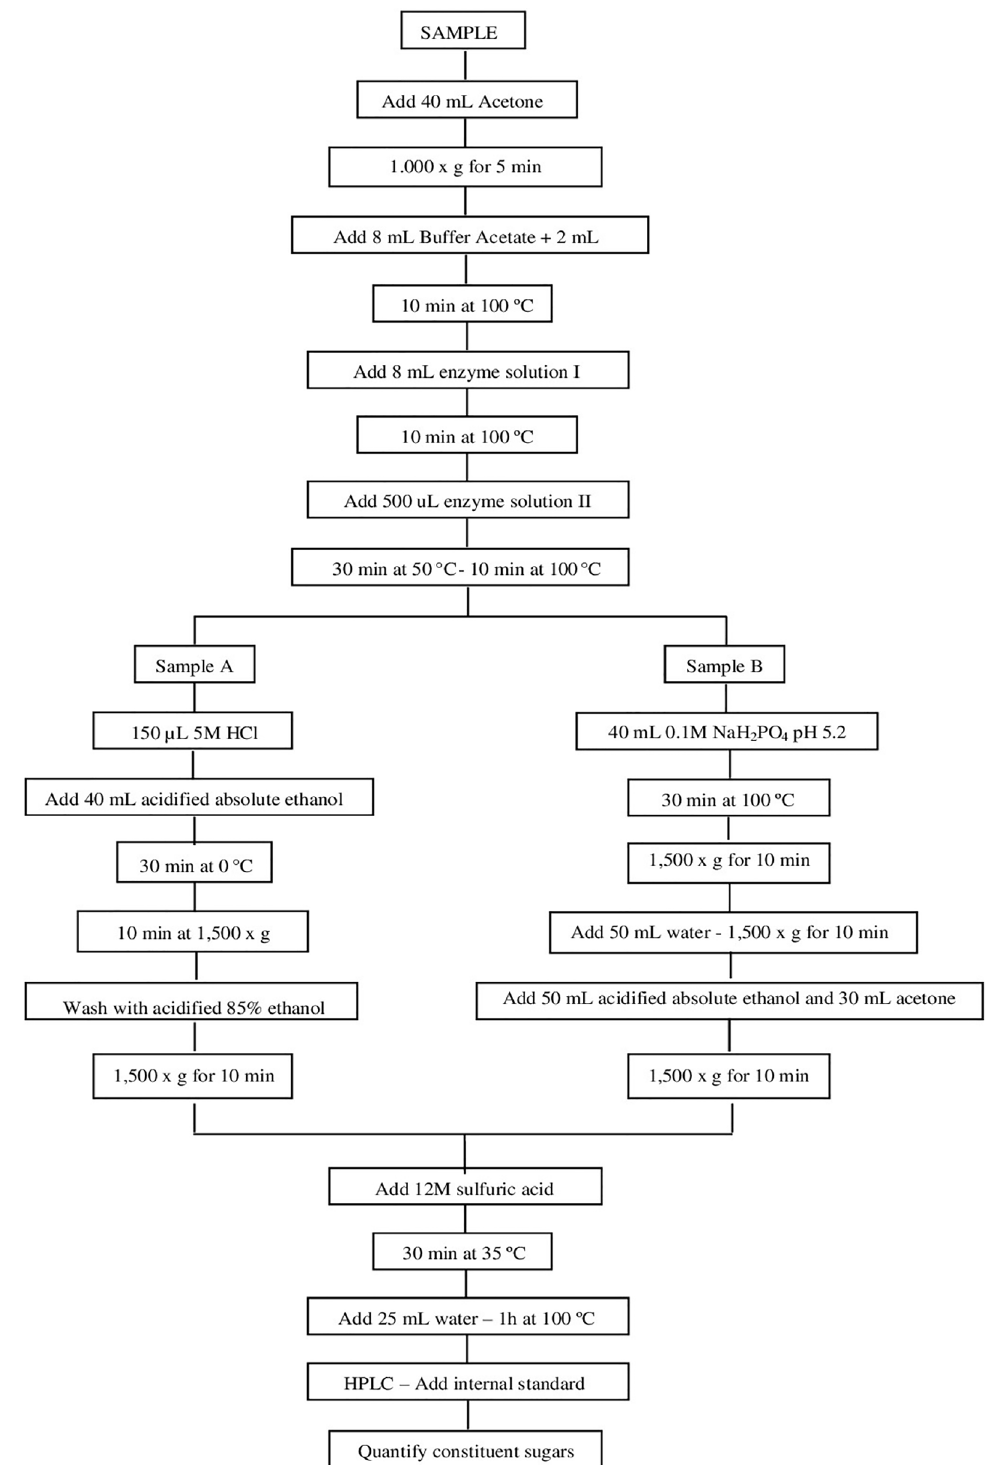
Figure 1 - Flow chart illustrating the common hydrolysis steps and specific treatments for quantification of NSP monosaccharide constituents. Adapted from Englyst et al.